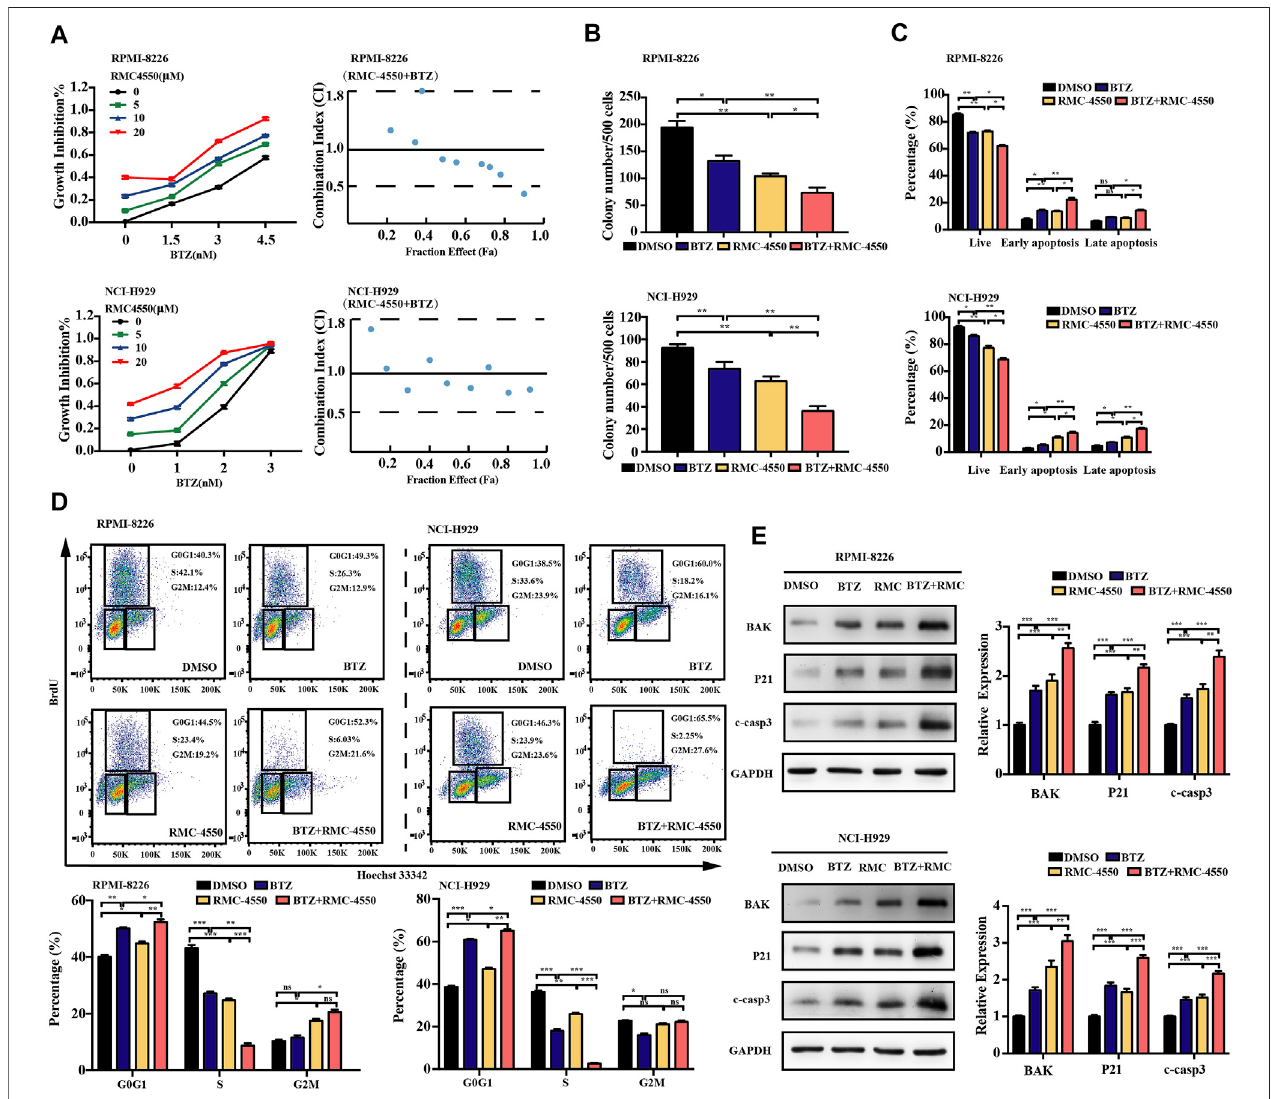
FIGURE 7 | Combination of RMC-4550 and BTZ exhibits a synergistic antitumor effect against MM cells. (A) Cytotoxic effects of various doses of RMC-4550 and BTZ in monotherapy and in combination on MM cells determined by the CCK-8 assay. Fa-CI plot analysis of combination treatment of the two on RPMI-8226 and NCI- H929 cell viability was performed. x-axis, fractional effect concentrations; y-axis, CI. RPMI-8226 and NCI-H929 cells were culture in the presence ofDMSO, RMC-4550 (10 μ M),BTZ(3 nMforRPMI-8226and 2 nM forNCI-H929cells),or RMC-4550 plusBTZfor48 h, andthen colonyformation (B) , cellapoptosis (C), and cellcycle (D) were measured. The representative fl ow cytometric pro fi les of BrdU/Hoechst 33342 are shown. (E) Western blotting shows the levels of P21, BAK, and cleaved caspase-3 in myeloma cells with monotherapy or the combination of bortezomib and RMC4550 for 48 h. GAPDH served as a loading control. The graphs show the density volumes of the indicated proteins normalized to those in the control. Data were displayed as mean ± SD from three independent experiments. * p < 0.05, ** p < 0.01, and *** p < 0.001.